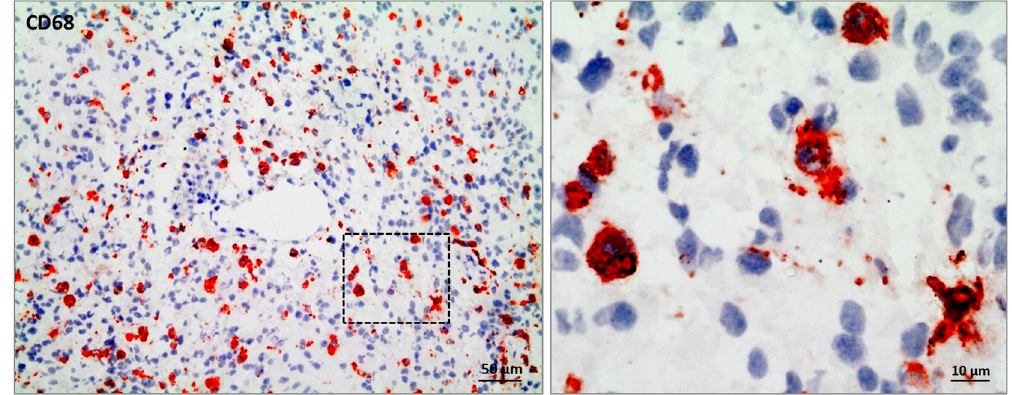
Figure 1. Immunohistochemical staining of CD68 to visualize glioma-associated microglia/macrophages in primary glioblastoma tissue of GBM patient NCH3242. Scale bar 50 µm, magnification 10 µm.